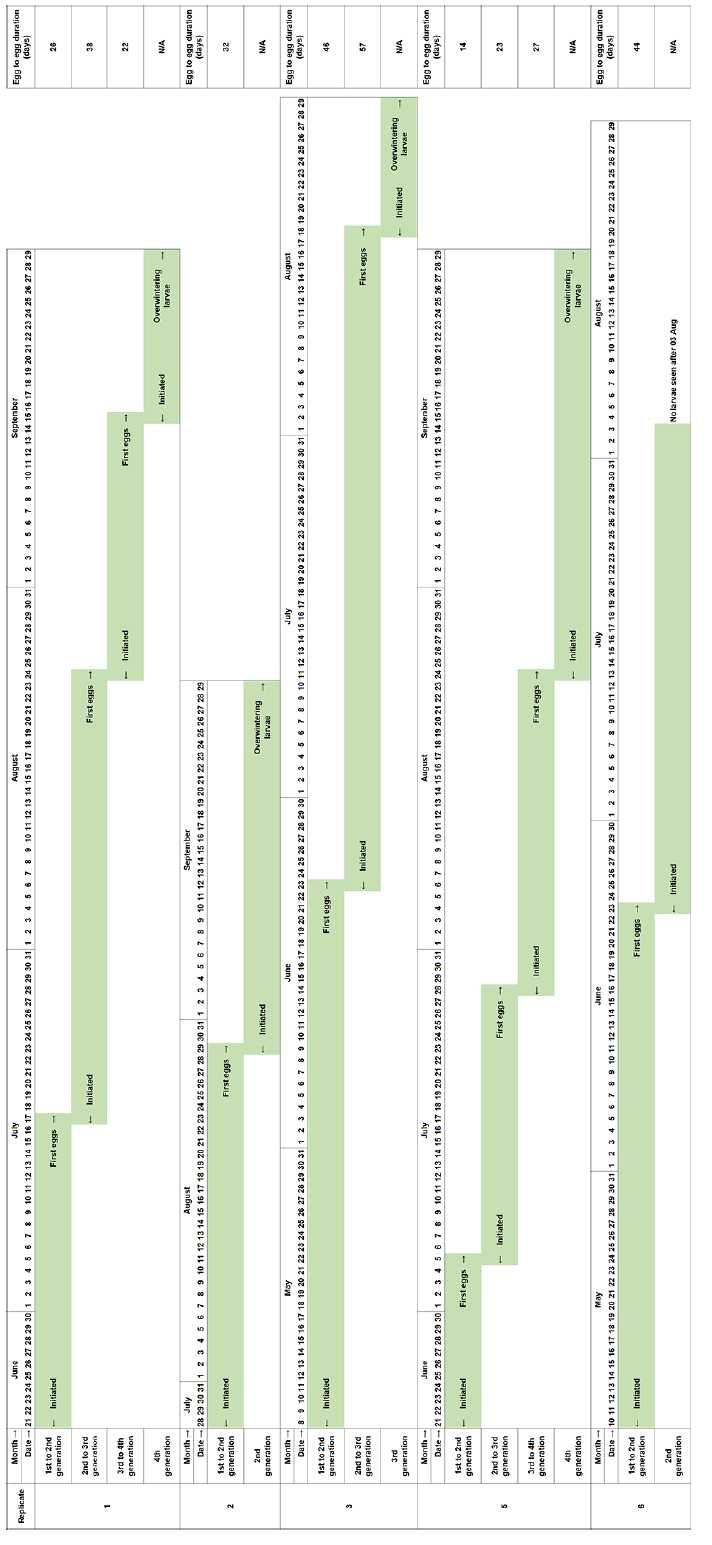
Figure 2. Development of C. crystallinus from introduced egg rafts in each microcosm that sustained populations in the life cycle study. Replicate 4 could not be reinitiated with egg rafts, as none were available at a suitable time. Monitoring of this unit showed that no larvae were present at any time, confirming the effectiveness of the systems in preventing colonisation by Chaoborus spp. from other sources.